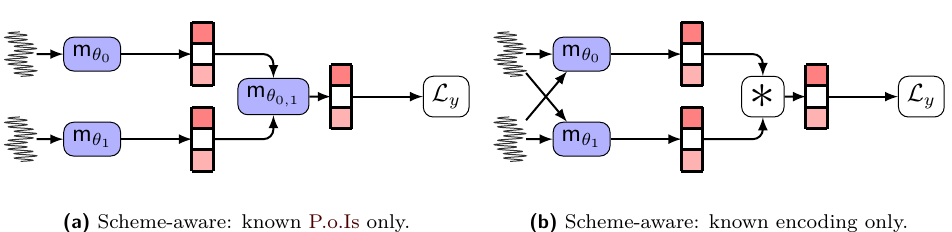
Figure 3: “Downgraded” scheme-aware models. In blue: blocks with trainable